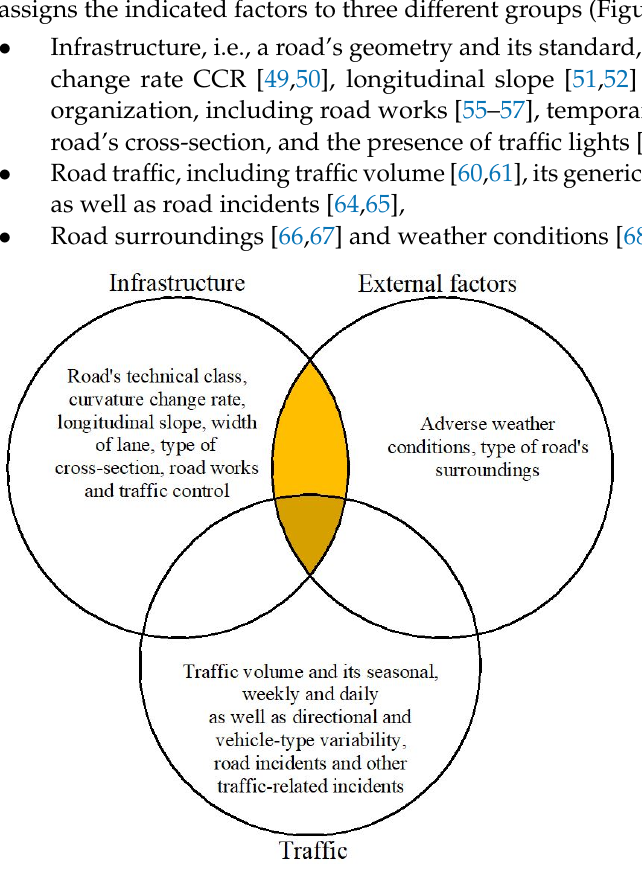
Figure 1. Interactions between sources of failure.